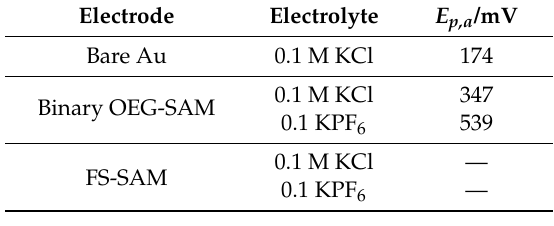
Table 4. CV results for 10 mM dopamine on different monolayer modified gold electrodes.